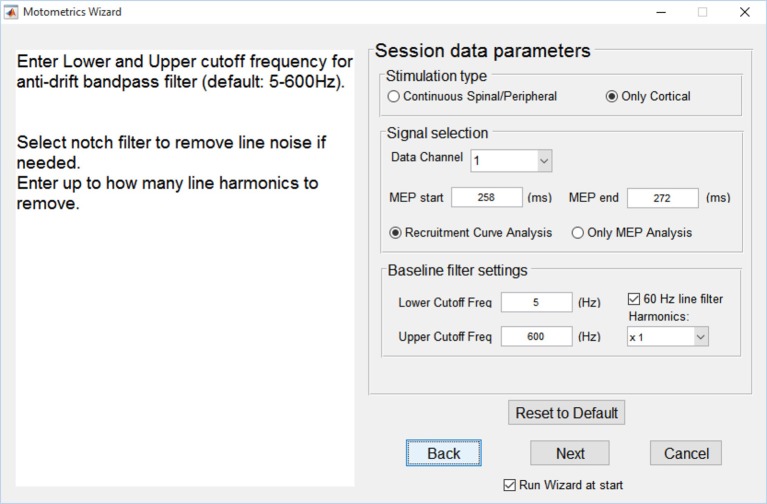
Motometrics wizard. The wizard guides the novice or unfamiliar user in selecting relevant parameter choices for configuring Motometrics. Each parameter is explained and acceptable ranges of values are suggested.